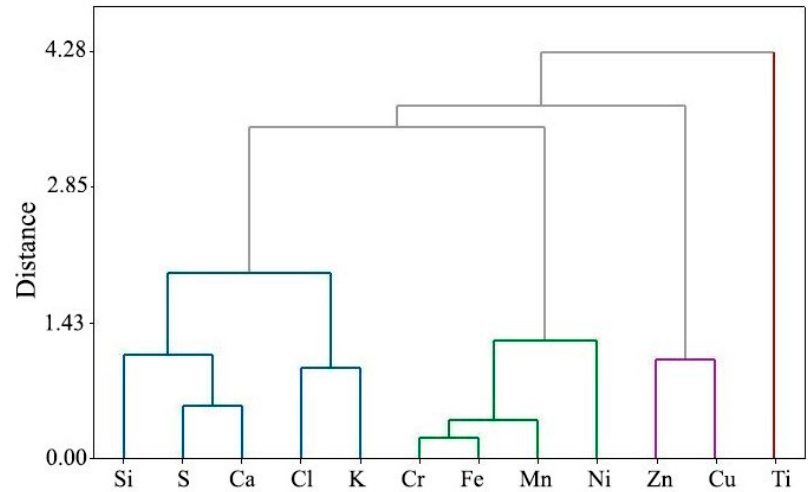
Figure 6. Dendrogram of the cluster analysis for PM 2.5 .